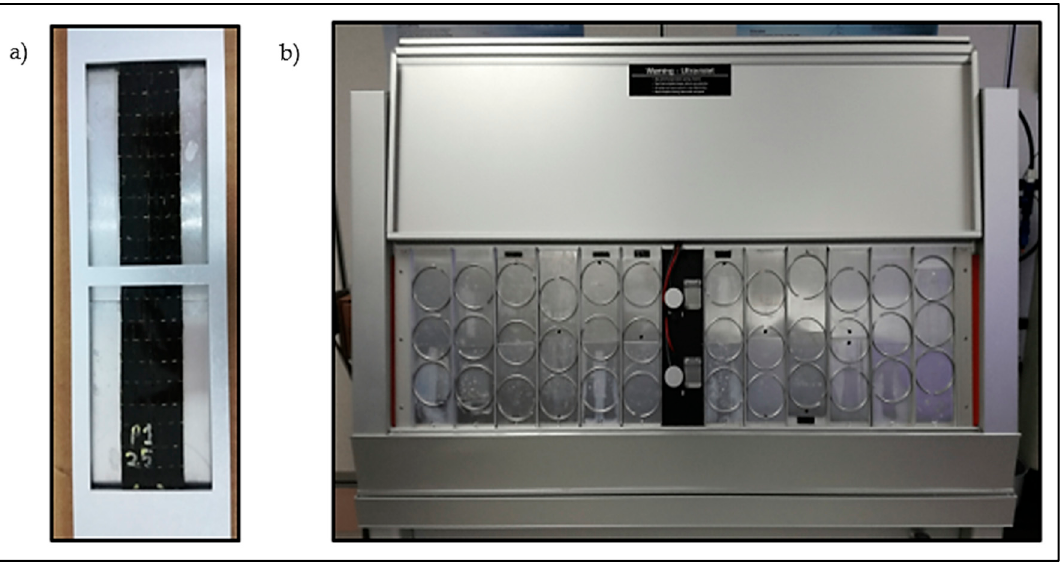
Figure 2. ( a ) Specimen mounted on the specimen holder, ( b ) setup of the specimen holder arrangement in the accelerated weather testing chamber.